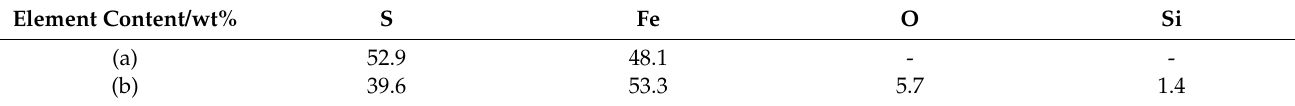
Table 9. Element content of selected area in (a) and